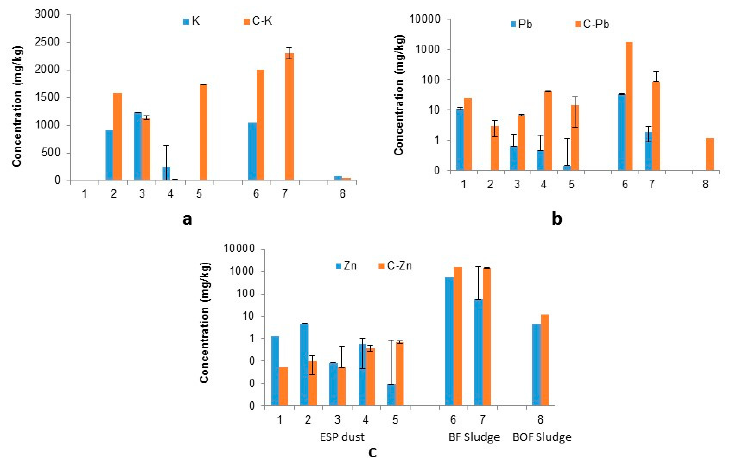
Figure 2. Concentration of ( a ) K, ( b ) Pb and ( c ) Zn (mg / kg) in solution after water and citric acid leach (C-Element refers to citrate-leached results) (Samples ESP dust: 1–5, BF sludge: 6–7, BOF sludge: 8).